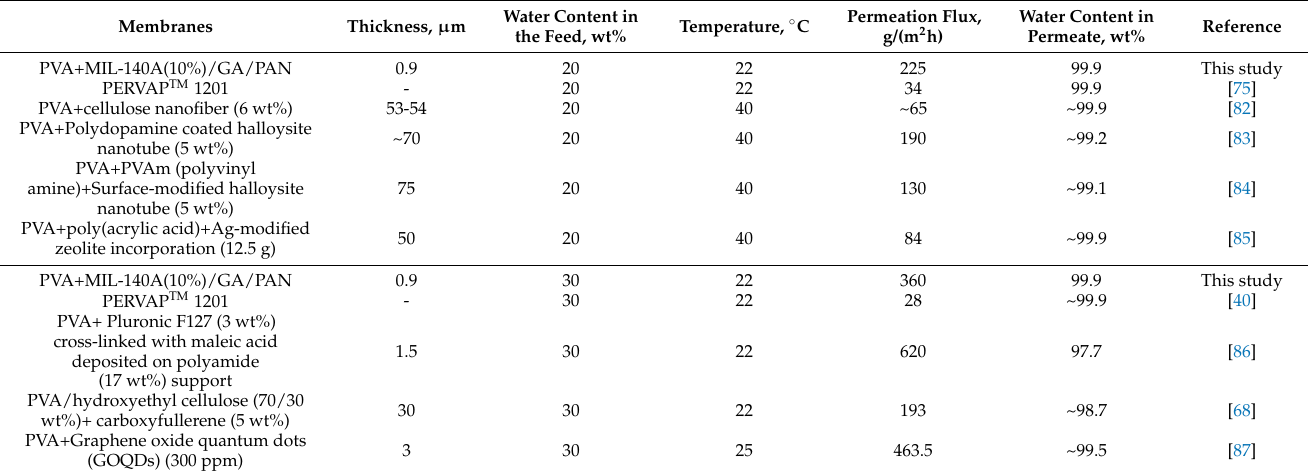
Pervaporation performance of the developed cross-linked composite PVA+MIL- 140A(10%)/GA/PAN membrane and literature-described PVA-based membranes applied for dehy- dration of isopropanol.